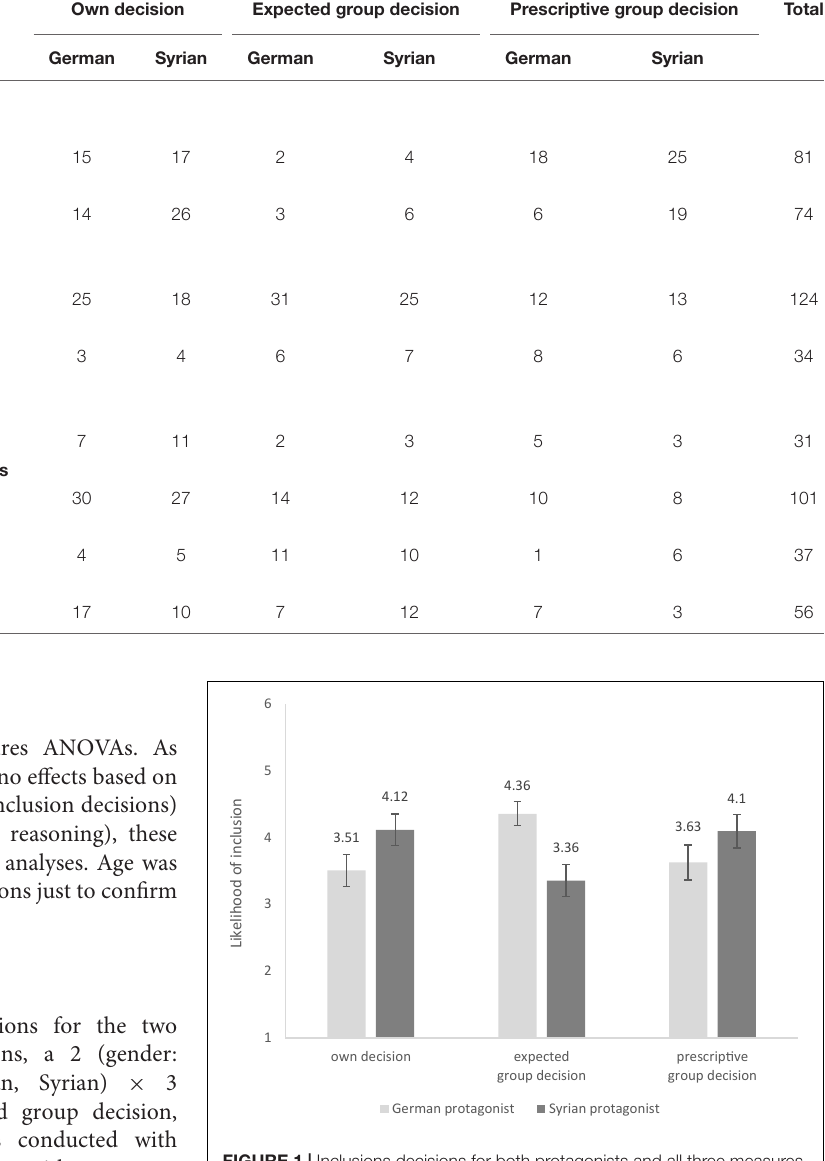
FIGURE 1 | Inclusions decisions for both protagonists and all three measures. High values indicate a high likelihood include the respective